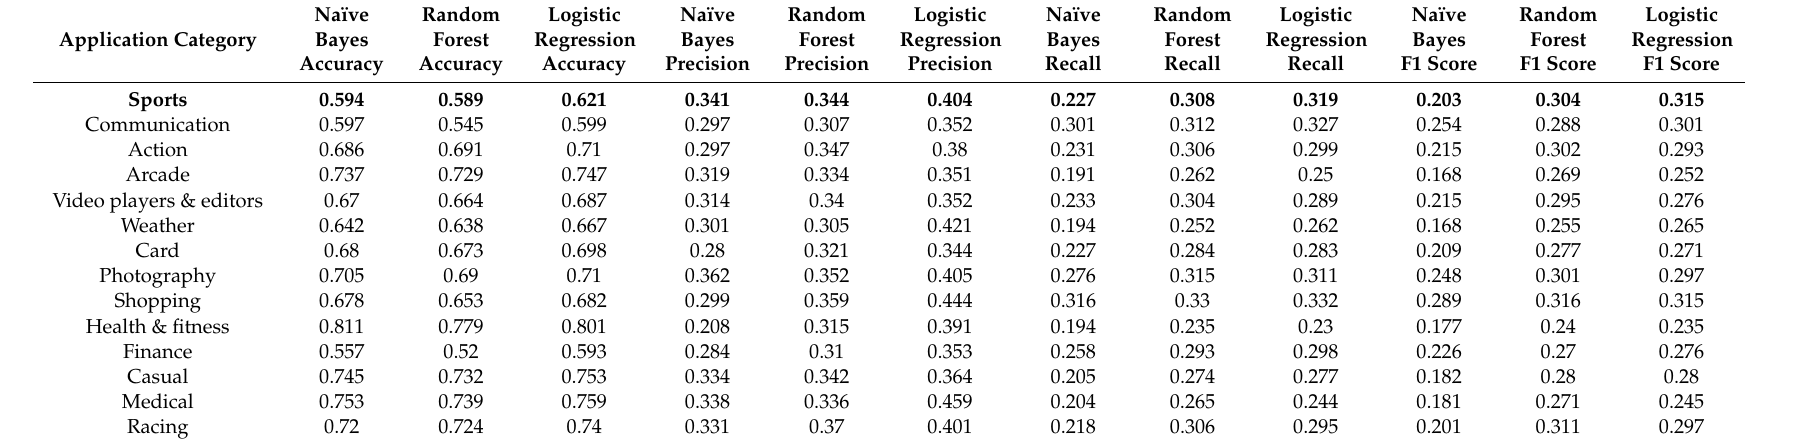
Table 3. Di ff erent machine-learning algorithm comparison of TF / IDF-based data after